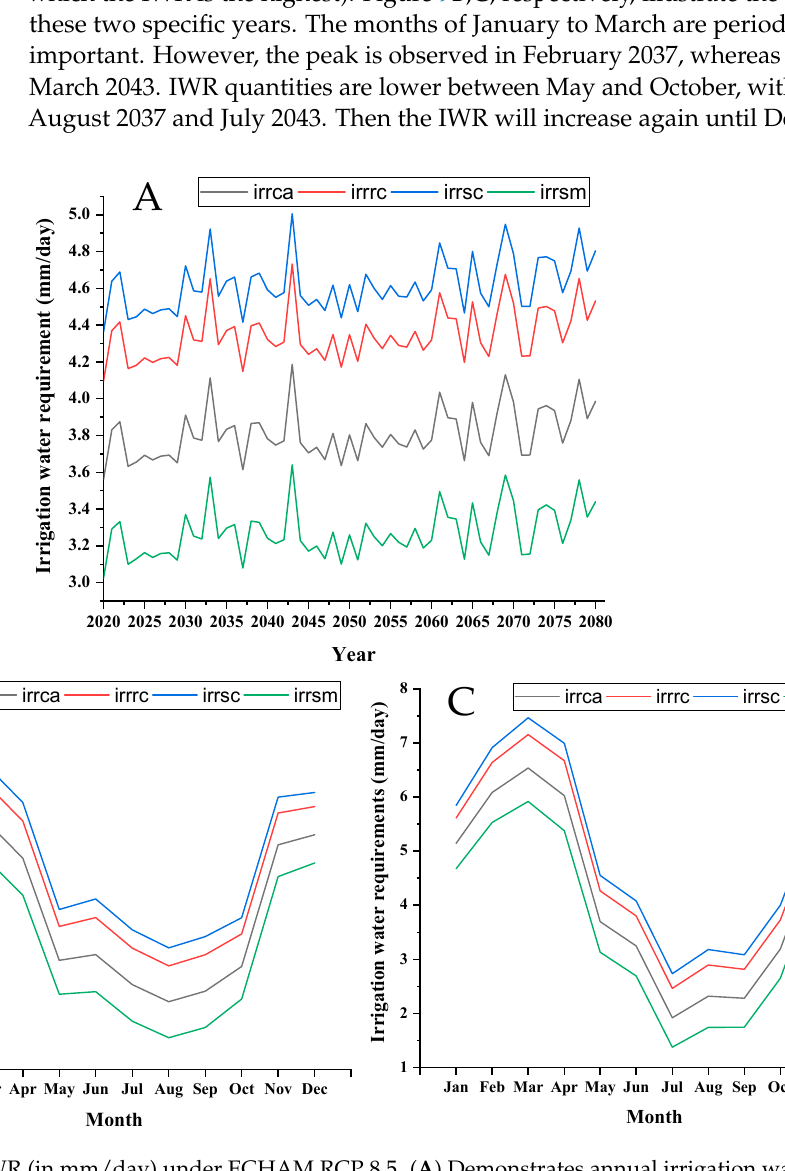
Figure 9. Evolution of IWR (in mm/day) under ECHAM RCP 8.5. ( A ) Demonstrates annual irrigation water requirements. ( B ) Demonstrates monthly irrigation water requirements for 2037, with the lowest irrigation water requirements by crops. ( C ) Demonstrates monthly irrigation water requirements for 2043 with the highest irrigation water requirements by crops. Same as Figure 3.